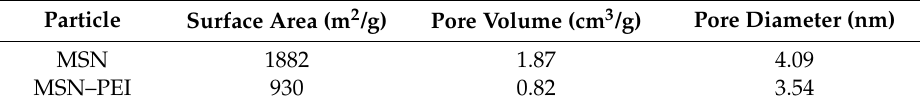
Table 1. Surface area, pore volume and pore size of the MSN and MSN–PEI particles. Particle